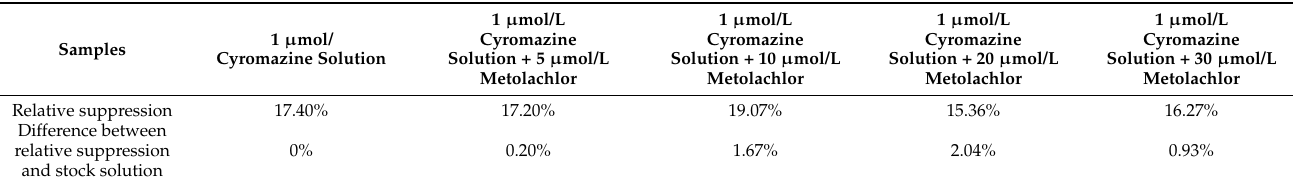
Table 1. Test results of the sensor ’ s resistance to atrazine interference.